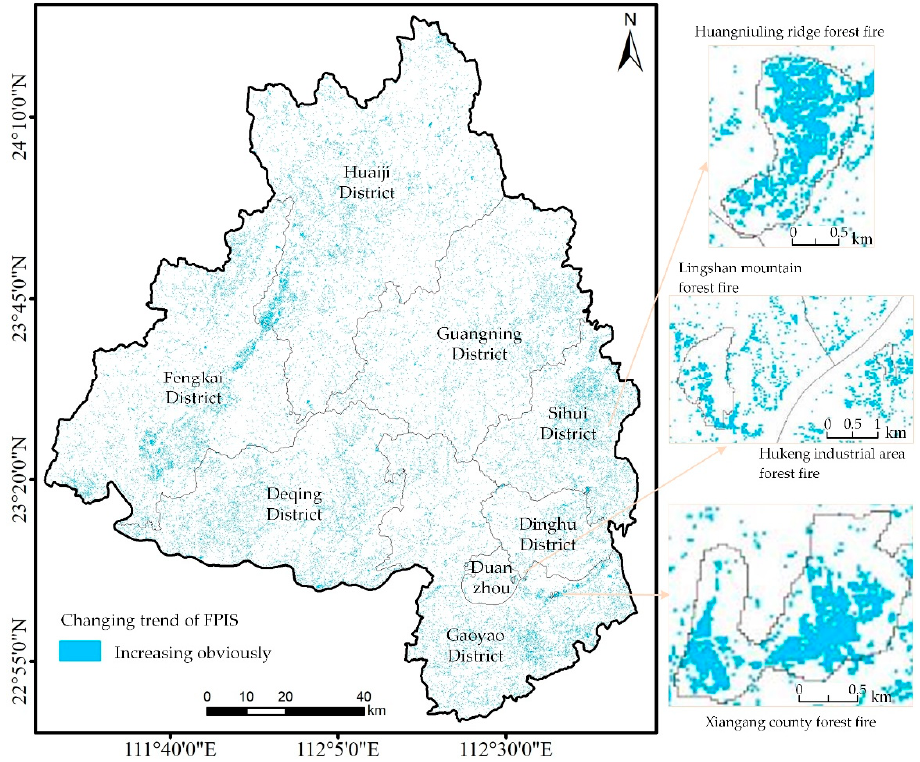
Figure 7. The changing trend of forest fire risk in Zhaoqing city in dry season, 2019 .